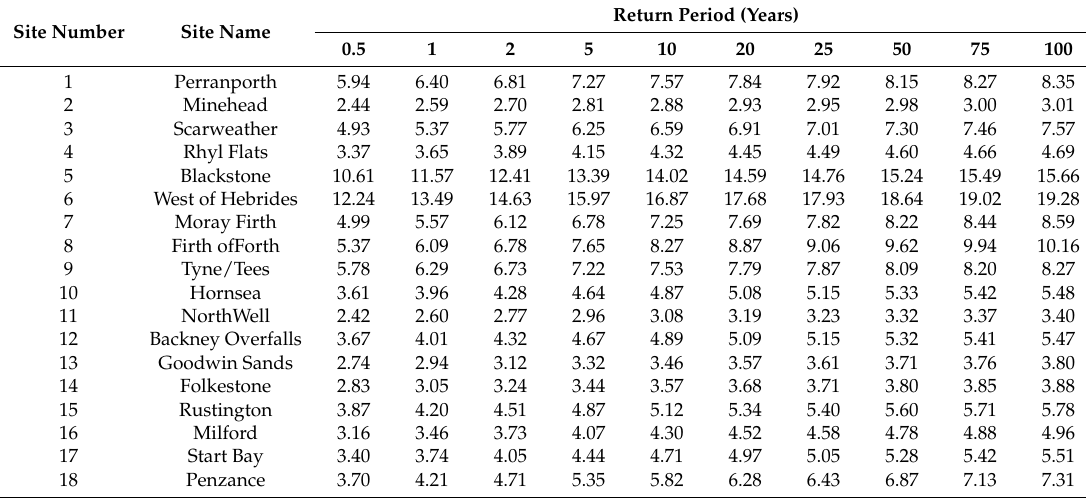
Table 2. Hs return level estimates (meters) for each of the 18 study sites for different return periods. Site